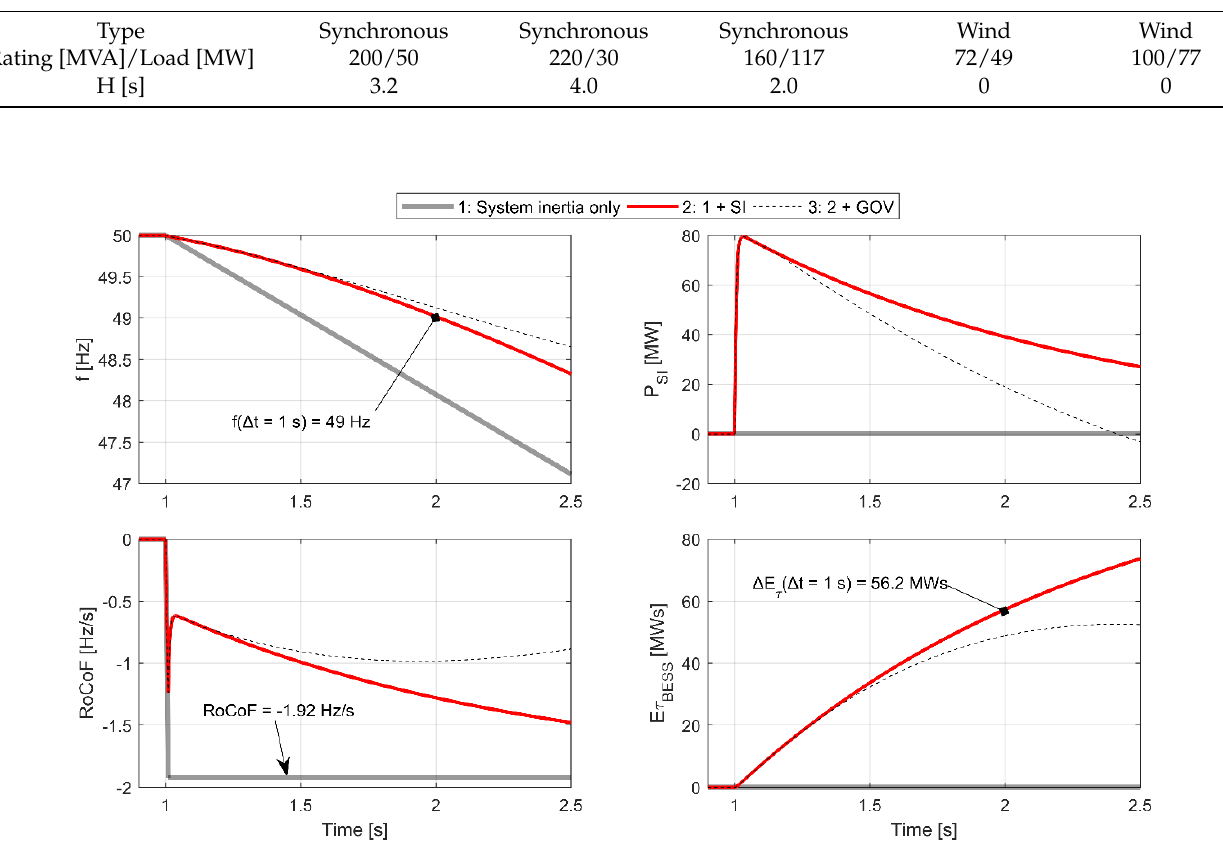
Figure 4. Single line diagram of the modified 14-bus IEEE system with BESS added to bus 12; the BESS model is a generic current injection model with WECC BESS Control System for RMS simulation [33] ( left ) and equivalent block diagram for this model in a lumped form ( right ). Table 1. Operating point of generators in the modified 14-bus IEEE system.